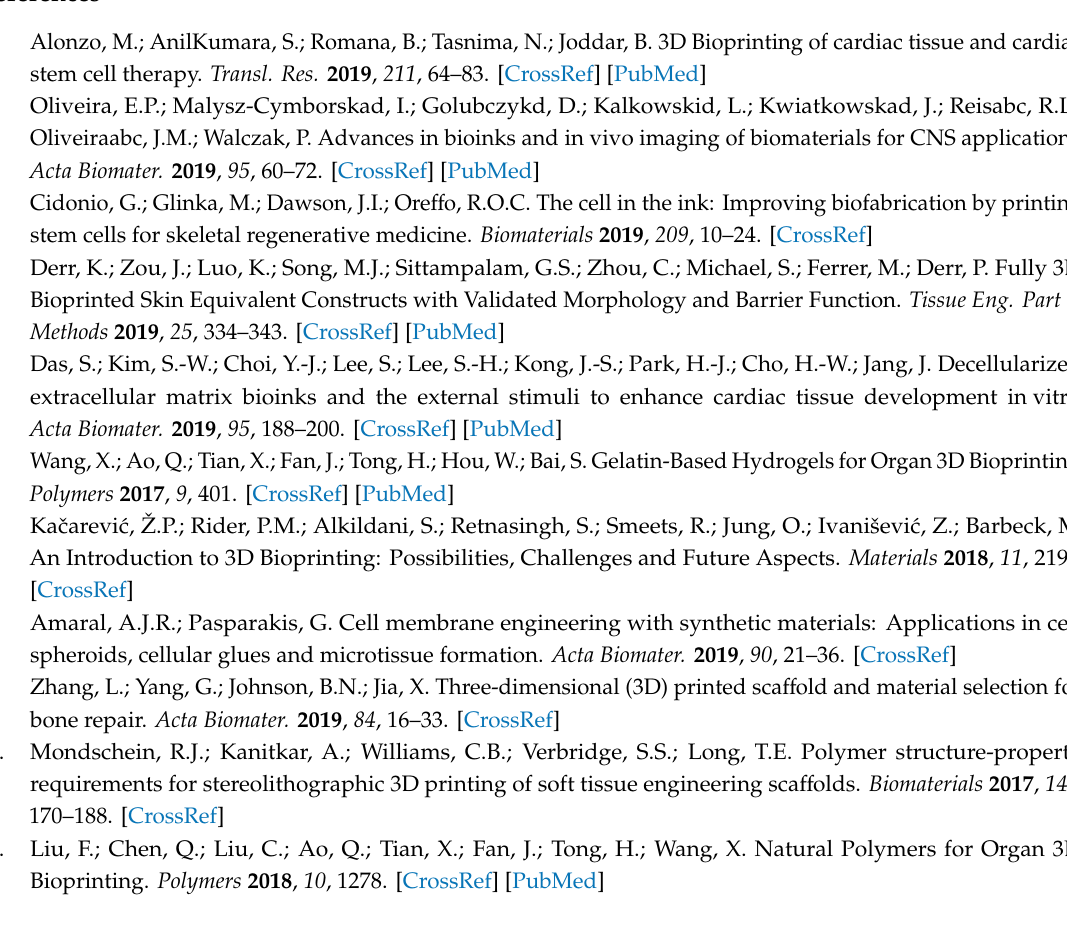
beads onto the needle array. Video S4: Printing of two layers of alginate beads onto the needle array. Spreadsheet S1: Major data for figures including e ffi ciency data, colocalization data, and alginate bead diameter data. Image S1: Immunolabeling of hiPSC